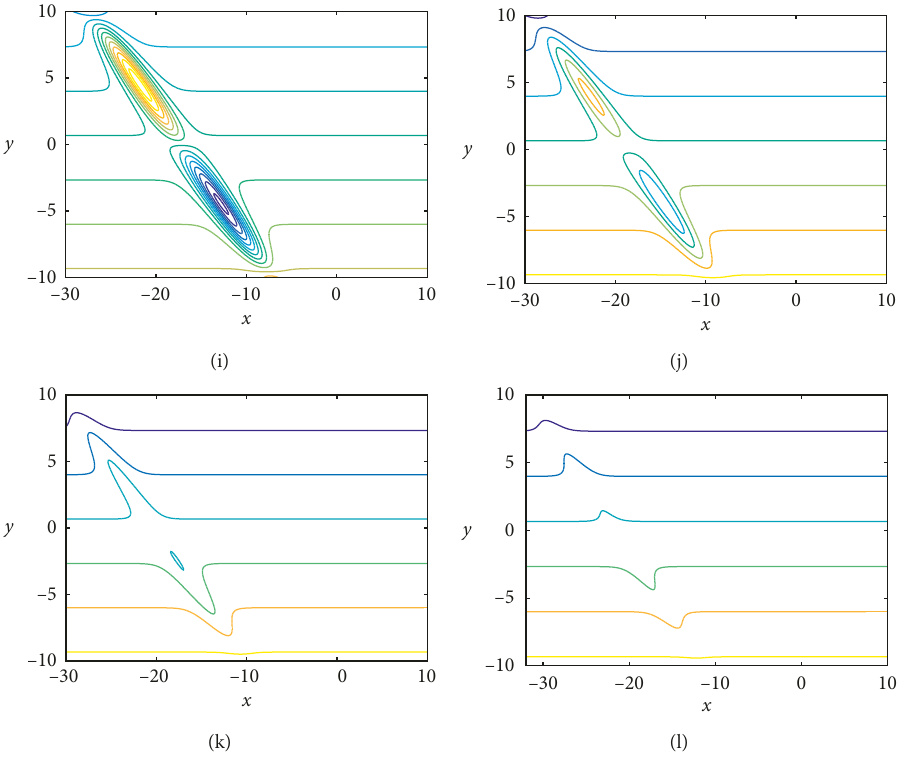
Figure 1: An atmospheric dipole blocking evolution with time from the theoretical solution of (45); other functions and parameters are given by (46)–(49). (a) Day 1, (b) day 2, (c) day 3, (d) day 4, (e) day 5, (f) day 6, (g) day 7, (h) day 8, (i) day 9, (j) day 10, (k) day 11, and (l) day